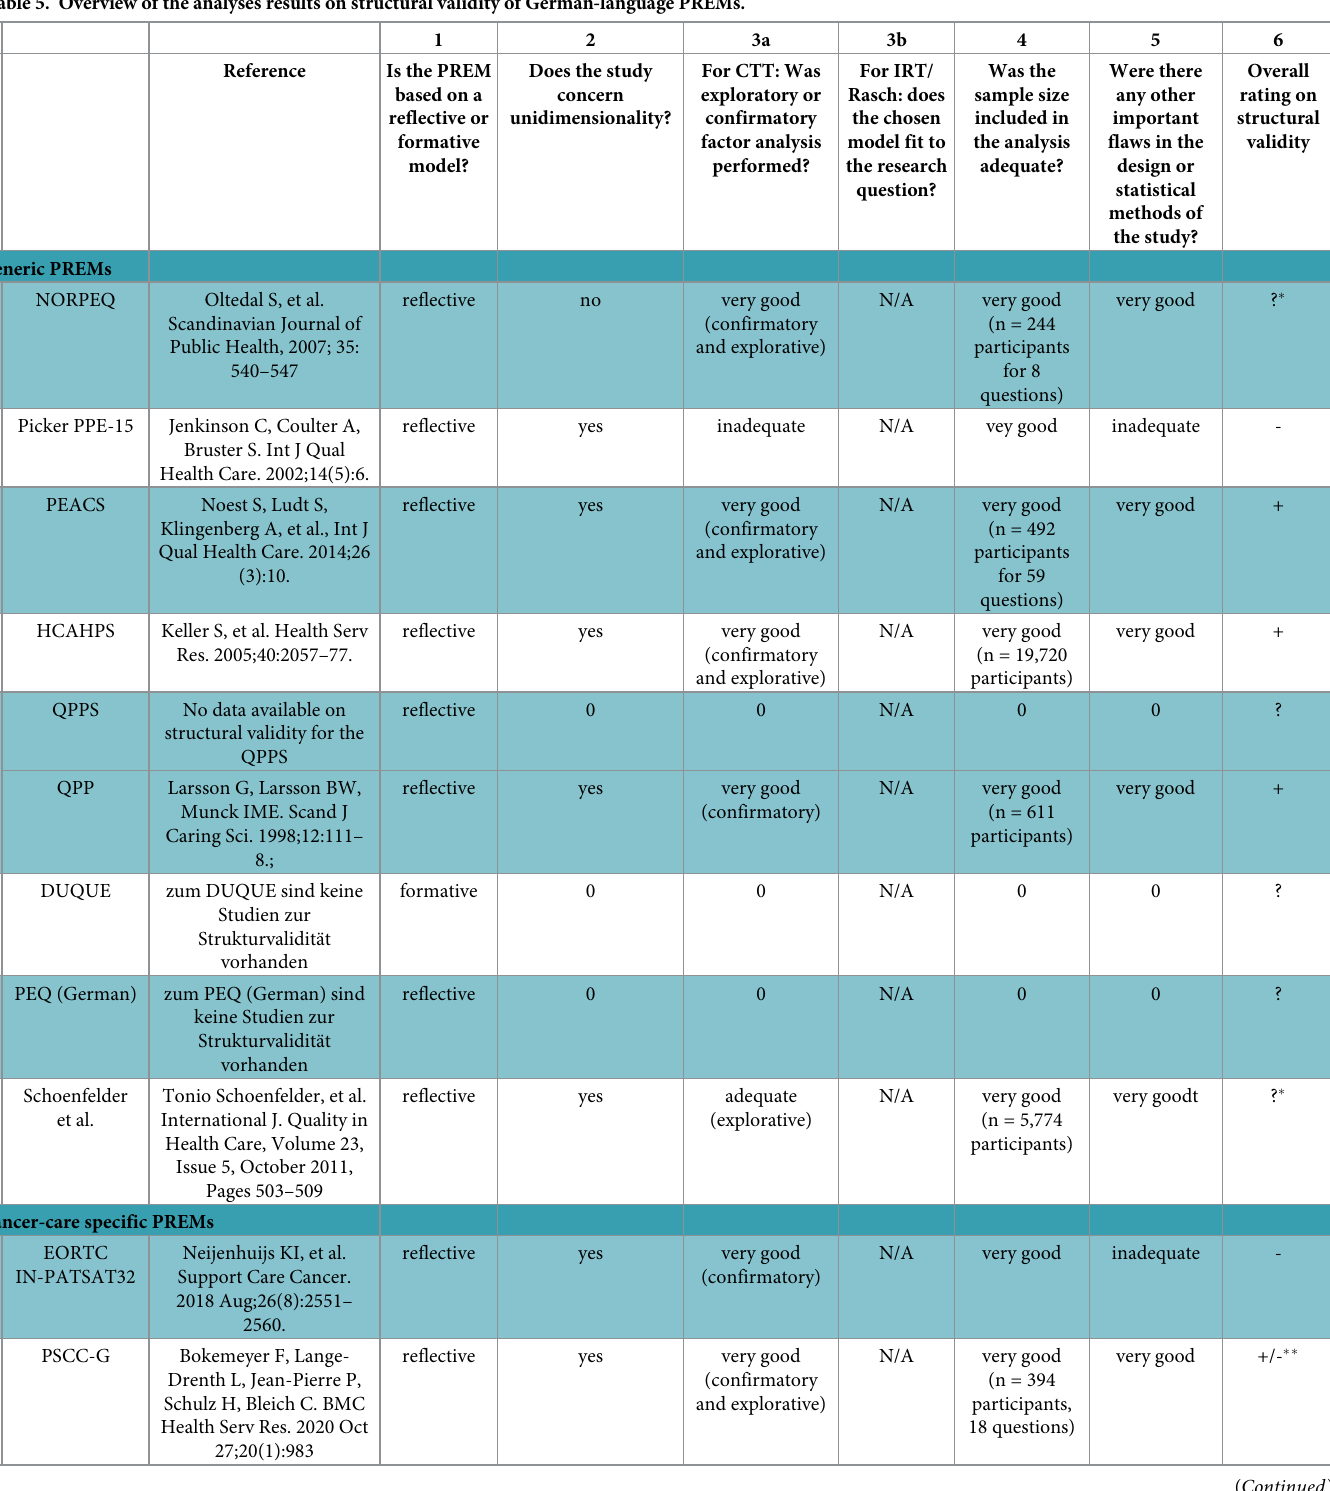
Table 5. Overview of the analyses results on structural validity of German-language